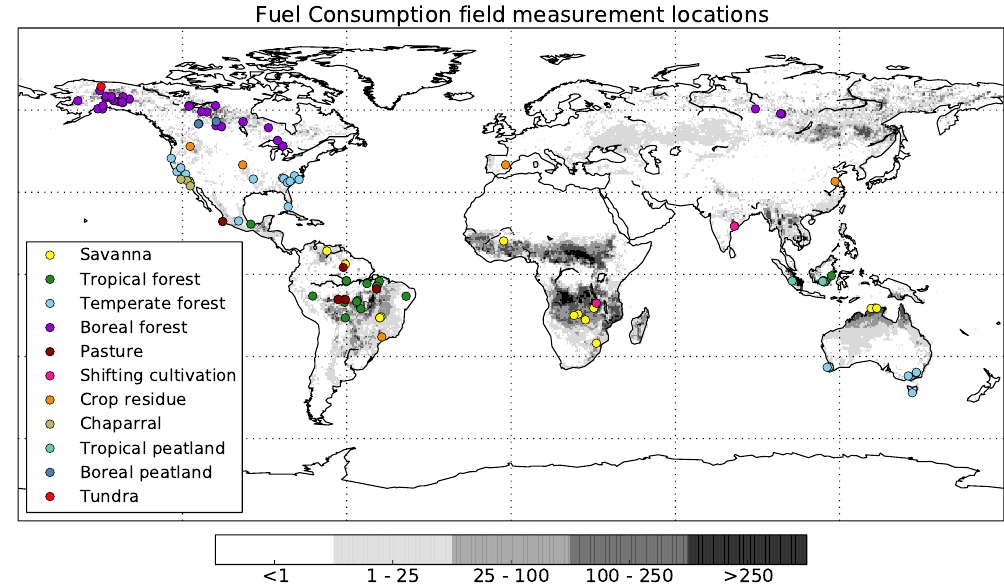
Figure 1. Fuel consumption field measurement locations for different biomes. Background map shows annual GFED3 fire C emissions in gCm − 2 year − 1 , averaged over